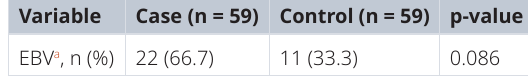
Table 2. Prevalence of EBV DNA in GCF samples.